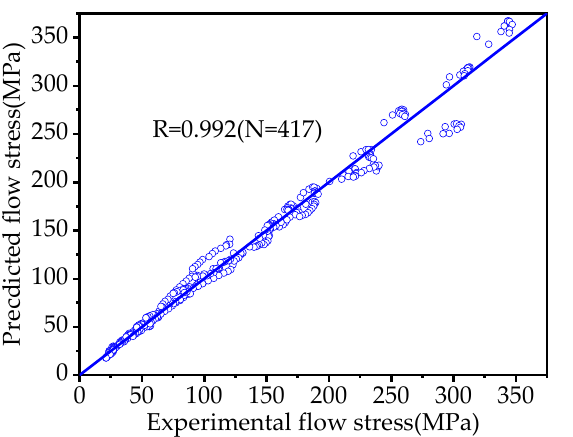
Figure 6. Correlation analysis of the experimental and predicted flow stress under all conditions of the Ti − 65541 alloy.